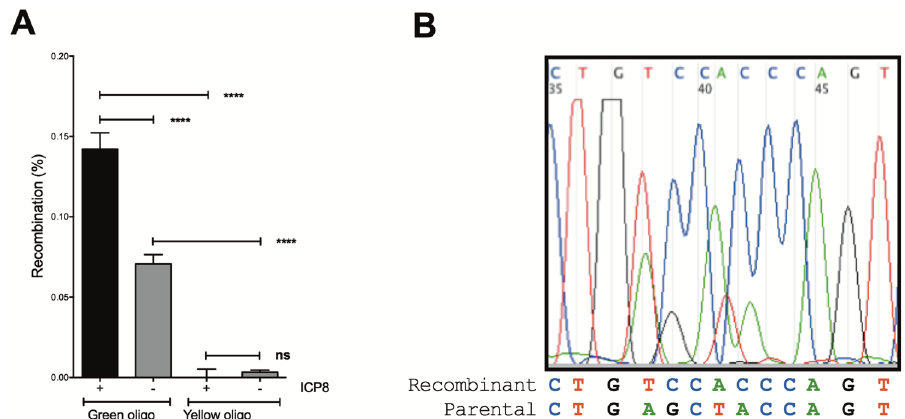
Fig 4. Transfer of the oligo sequence to the genome is required to change cell fluorescence. A) The Green recombinant phenotype requires a Green oligo substrate. Yellow to Green phenotypic conversion was evaluated by transient transfection with pCMV-ICP8 followed by transfection with 200 nM Green or Yellow oligos (85 and 131 respectively). B) Recombinant cells acquire the oligo sequence. A recombinant cell mixture was sorted for Green fluorescent cells. Genomic DNA was isolated from sorted cells enriched for putative recombinants. The target region was amplified by PCR and the products treated with restriction enzyme AluI to cut non-recombinant sequences. Uncut fragments were gel extracted and sequenced using primer 216. The original Parental sequence and the predicted Recombinant sequence is shown. Details of this experiment can be found in S1 Extended Methods under Determination of recombinant